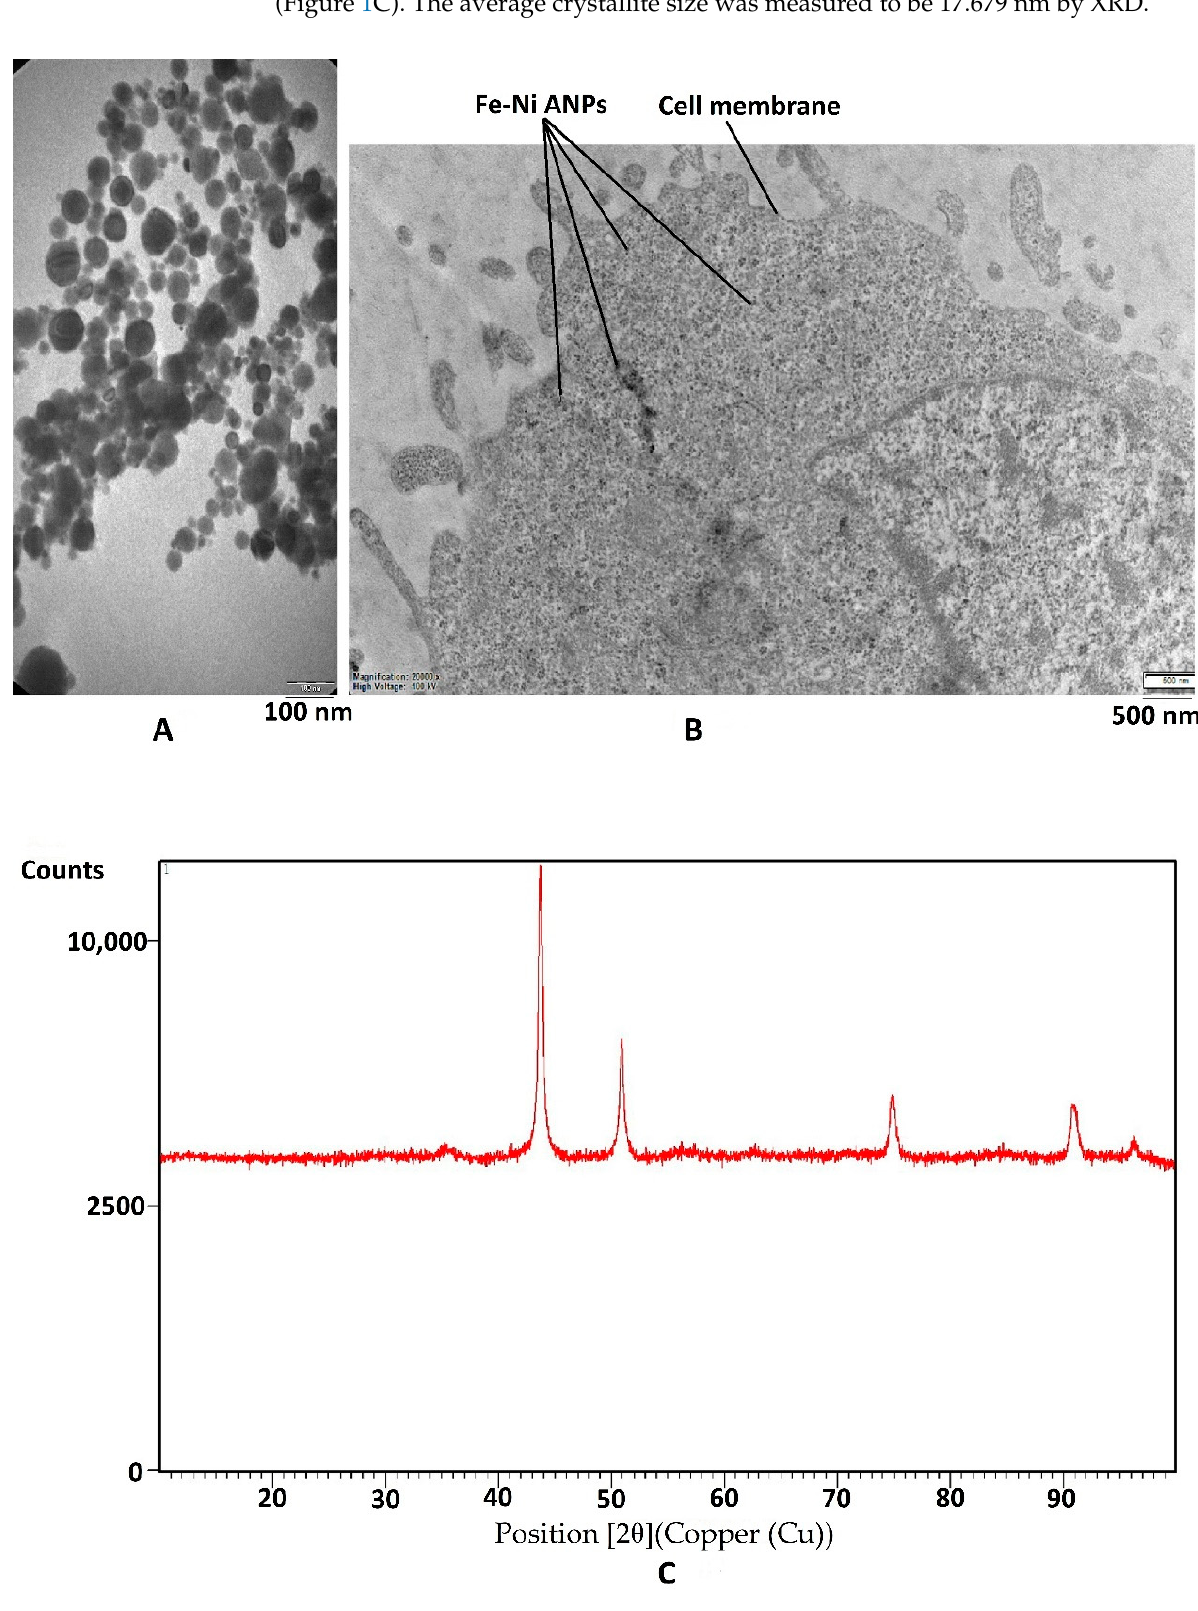
Figure 1. Characterization of nanoparticles. ( A ) Sample TEM image of Fe–Ni ANPs. ( B ) Sample intracellular TEM image of Fe-Ni ANPs. ( C ) XRD pattern of Fe-Ni ANPs.